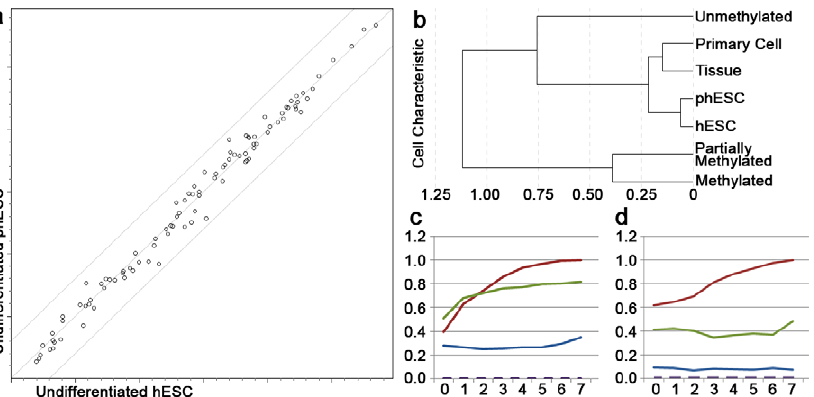
Figure 2. Undifferentiated colonies differed with respect to imprinted genes. PCR arrays did not reveal differences in the undifferentiated state (a). Parthenote-derived lines LLC6P and LLC8P are plotted on the y-axis and conventionally-derived lines H7 and CSC14 on the x-axis. Methylation microarray revealed differences between parthenote-derived lines and conventionally-derived lines, most notably in imprinted genes. Cluster analysis (b) indicated that phESC and hESC were closely related to each other and more methylated than tissue and primary cell lines. phESC and hESC are distinguishable when complete methylation data are included (c). phESC and hESC diverge further when methylation data include only imprinted genes (d). Methylation data, normalized with tissue lines as the unmethylated baseline (c and d). In c and d, correlation is plotted on the y- axis and level of discordance between 7 phESC lines is plotted on the x axis (e.g. 4 means 3 phESC lines were allowed discordance). Red represents phESC lines, green represents hESC lines, blue represents primary cell lines and dashed purple represents tissue lines.